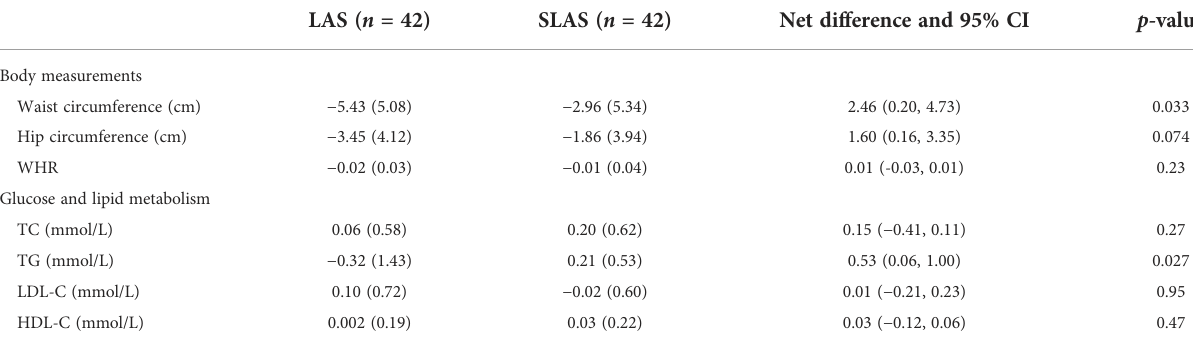
TABLE 4 Change of secondary outcomes after treatment.